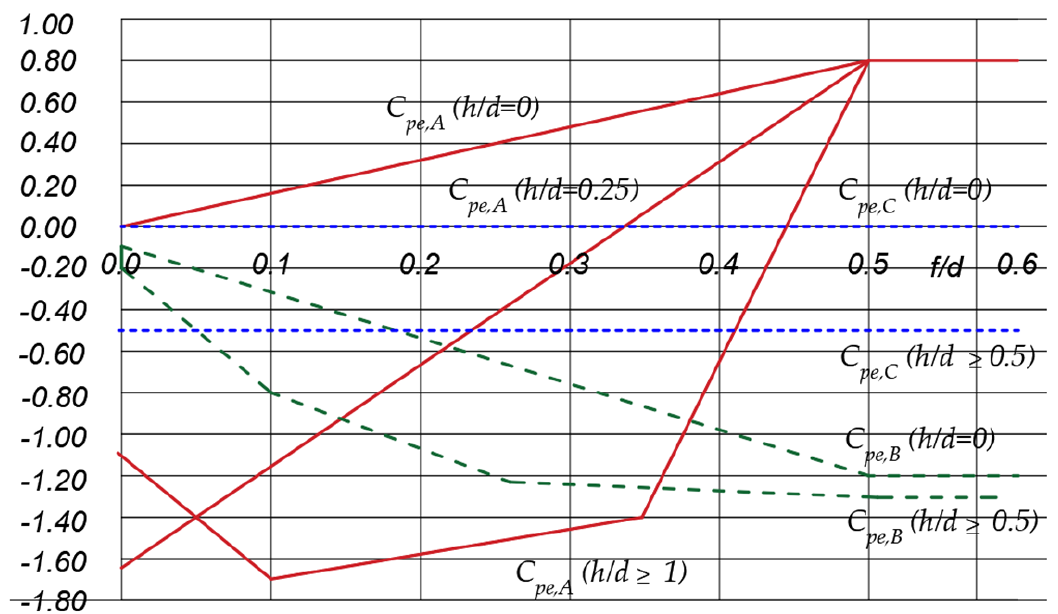
Figure 12. Diagram of the structure division into wind zones acc. [39].